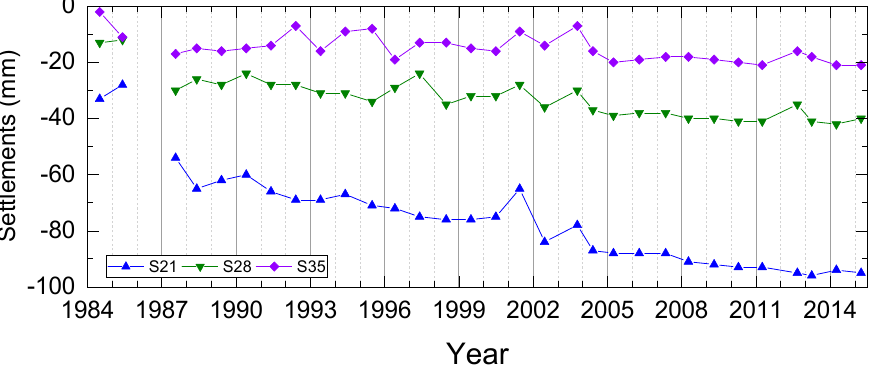
Figure 7. Monthly averages of reservoir level and observed settlements of control stations along cross-section A-A (see Figure 3 for location). The settlements of the control stations on the downstream shoulder (bottom plot) are plotted at a different y-axis scale for easier comparisons.